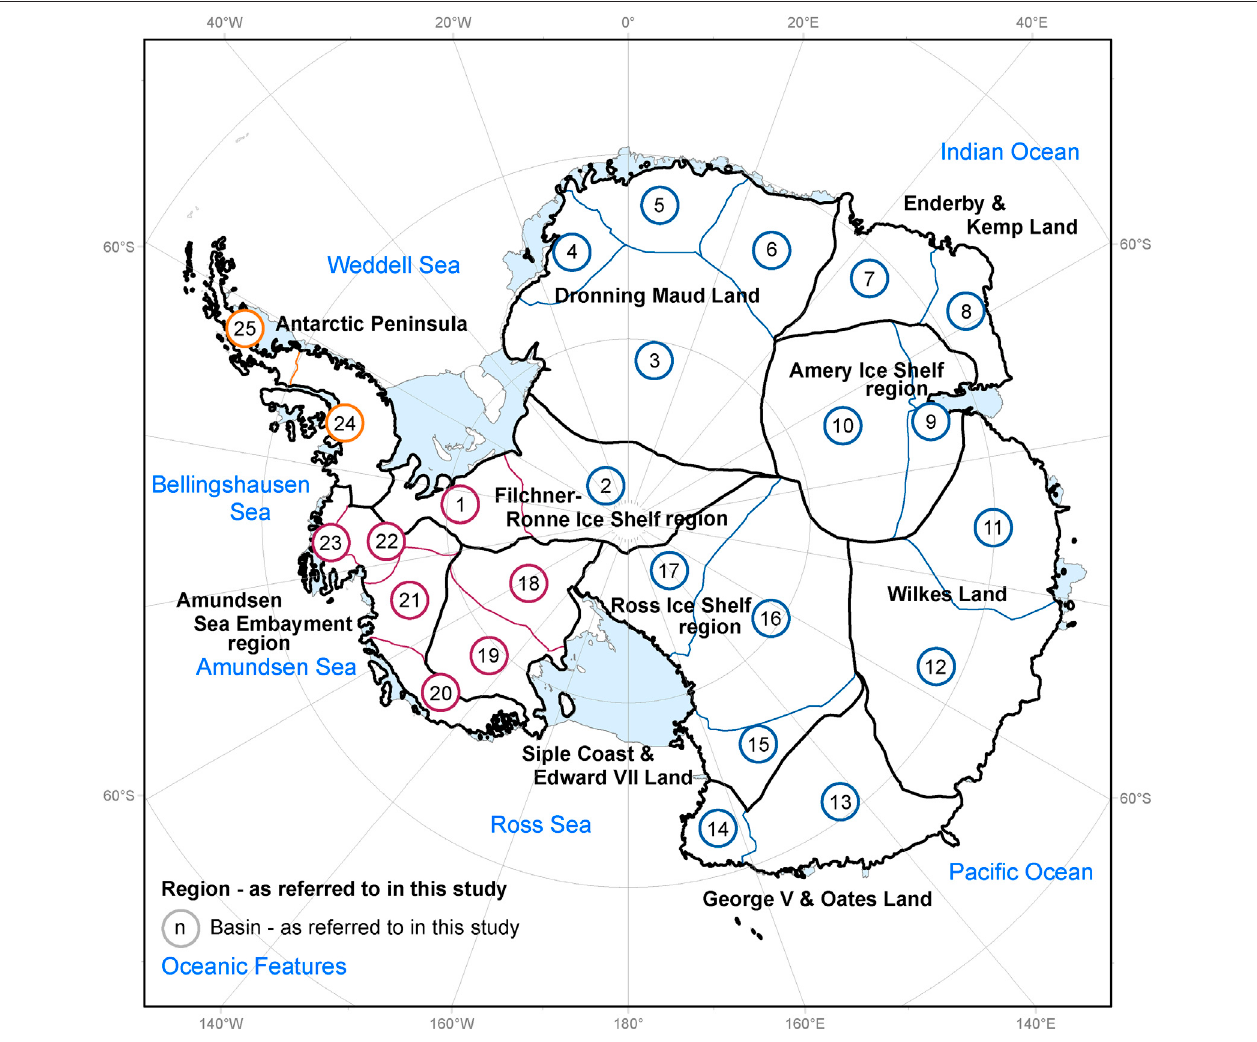
FIGURE1| DrainagebasinsandregionaldivisionoftheAntarcticIceSheet.ThecontinentalAntarcticIceSheetisdividedinto25drainagebasinsfollowingSasgen et al. (2013). The basins are further grouped into ten larger entities (regions), named according to their characteristic geographical feature, such as the adjacent ocean embayment or ice shelf (black lines). The basins are attributed to East Antarctica (blue lines), West Antarctica (red lines) and the Antarctic Peninsula (yellow lines). Labels locate geographicfeaturesdiscussed inthe text. The projection isPolar Stereographic centered at 90 ° Sand 0 ° E,with the true latitude of71 ° Sand WGS84 (EPSG: